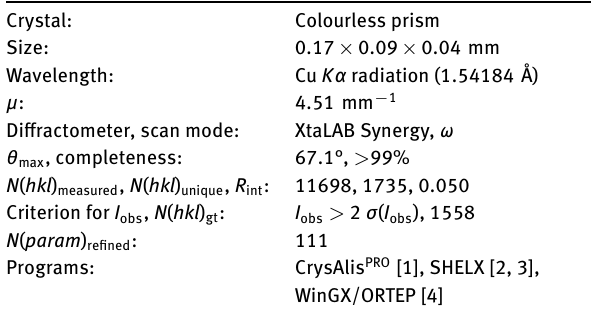
Table 2: Fractional atomic coordinates and isotropic or